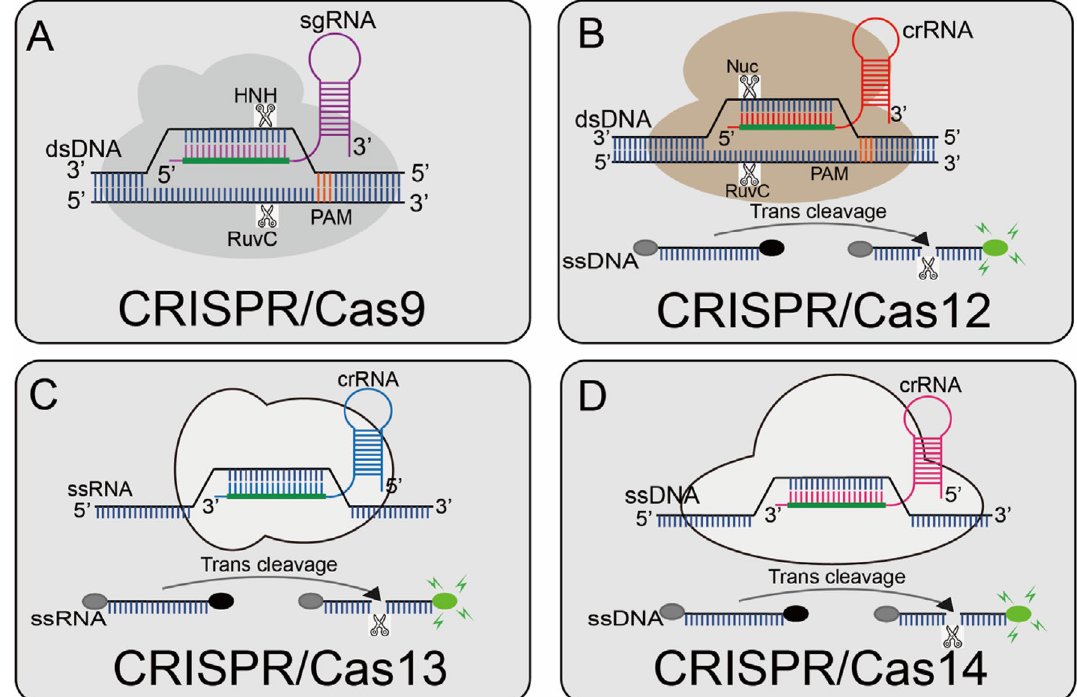
Fig. 1 Overview of CRISPR-Cas enzyme activities and their catalytic mechanisms. A Cas9 can cleave the target and non-target strands of DNA; a short trinucleotide PAM is also essential for the initial DNA binding; B Cas12a can cleave dsDNA under the guidance of gRNA. The Cas12a enzyme recognizes the PAM of the original T-rich spacer and then recognizes the target sequence to generate PAM distal dsDNA breaks with staggered 5 ′ and 3 ′ ends, and Cas12 has the side chains trans-cleavage activity. At the time that the sgRNA-guided DNA is combined in Cas12, Cas12 will release a powerful, indiscriminate single-stranded DNA (ssDNA) cleavage activity; C Cas13 can activate its single-stranded RNA (ssRNA) cleavage activity by binding to crRNA, and it has a additional cleavage activity triggered by the target RNA; D Cas14 protein is a RNA-guided nuclease and can recognize the target ssDNA without restriction sequences and cleave it, and also can non-specifically cleave the surrounding ssDNA nucleases molecule (Modified after: Li et al., Diagnostics 2022, 12(10); Copyright: CC BY